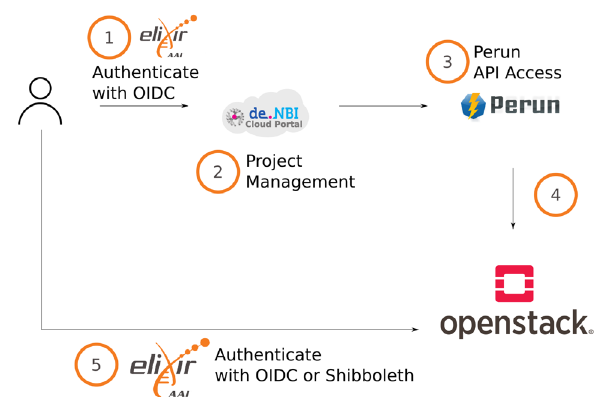
Figure 2. The user workflow which is implemented by the de.NBI Cloud Federation. 1. User logs in to the portal and applies for a project. 2. The Virtual Organisation manager configures the project. 3. Project configuration data is saved in Perun. 4. The project data is propagated to an OpenStack